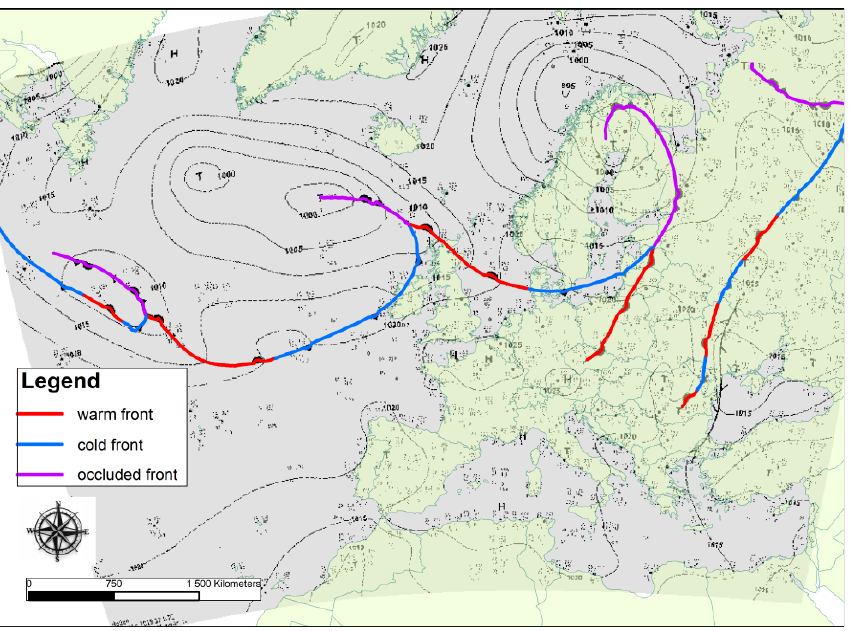
Figure 1. Example of the digitalization